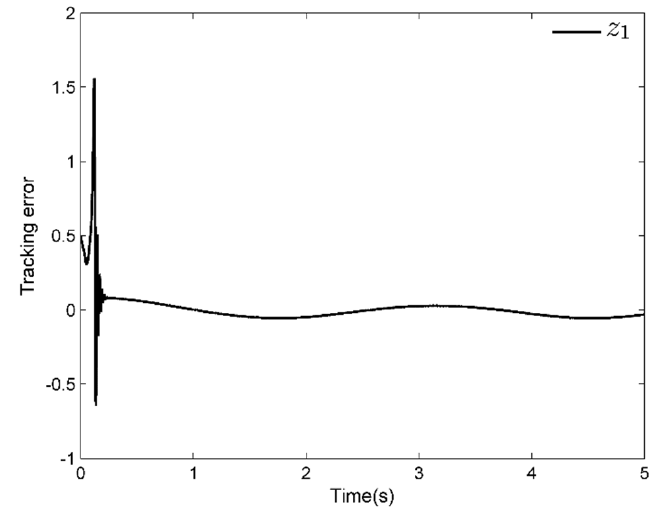
Figure 2. The trajectory of tracking error z 1 .